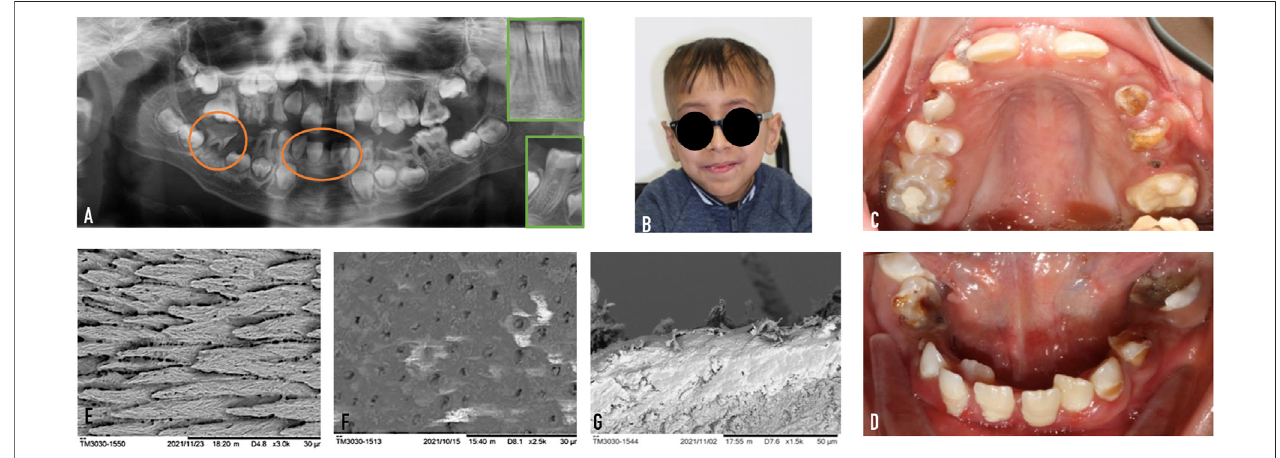
FIGURE 3 | Case report. (A) Orthopantomogram X-ray of our 10-year-old Singleton-Merten patient. In orange, a fi rst permanent molar (tooth n ° 46) and central permanent mandibular incisors (teeth n ° 31 – 41) with short roots were highlighted. To compare, a healthy patient ’ s teeth are shown in a green insert. (B) Photography of the patient. (C,D) Intra-oral photographies of the maxillary and the mandibular arch. (E) First molar enamel. (F) Second temporary molar dentin. (G) First molar cement.